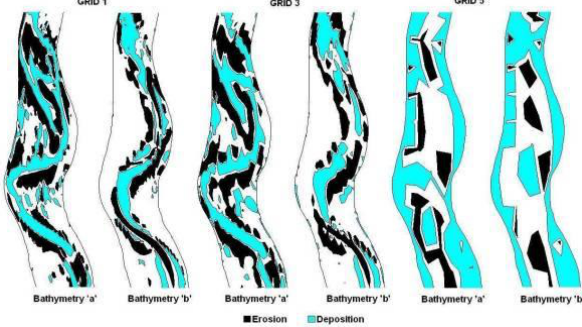
Figure 7. Erosional-depositional areas in a portion of the watercourse obtained with grids 1, 3, 5, and bathymetries „a‟-„b‟ 3.1.2 Flood modelling results : In simulations run using only 2D module, drainage effect due to channel presence is correctly represented only with high resolution DTMs.